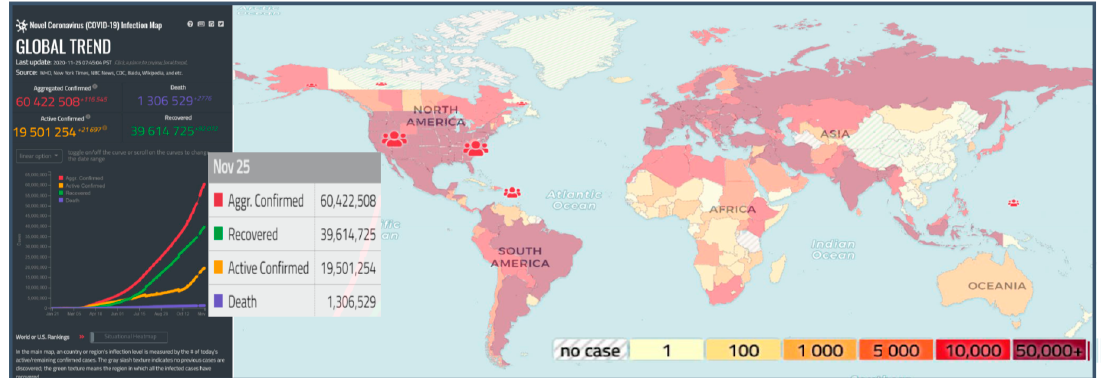
Figure 34. Epidemiological situation in various countries of the world on 25 November 2020 caused by the COVID-19 disease.